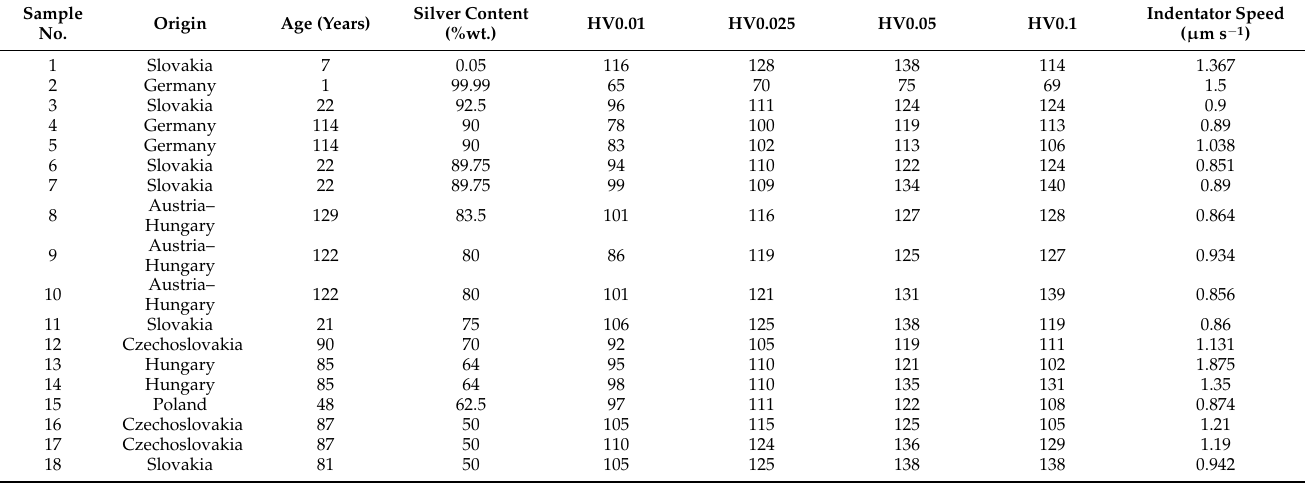
Table 1. Sample origin, age (years), silver content (% wt.), micro-hardness (HV0.01, HV0.025, HV0.05, HV0.1); the average speed of the indenter penetration into the sample for a load of 0.49035